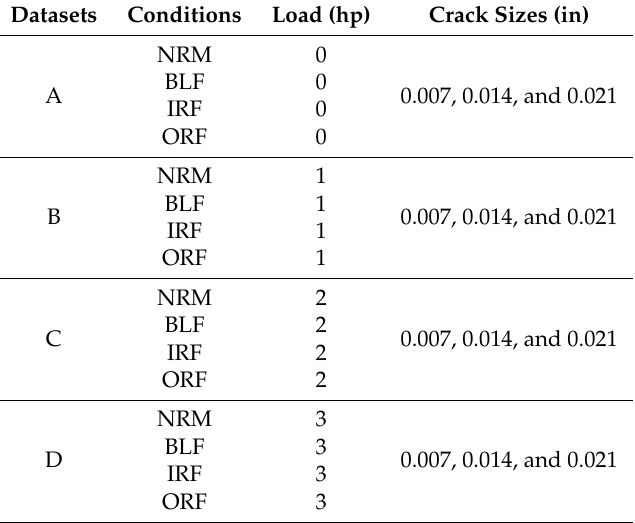
Table 1. Case Western Reserve University (CWRU) Vibration Datasets.